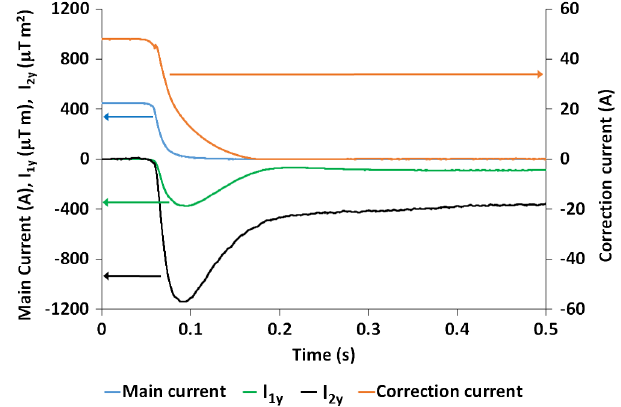
FIG. 12. Measured first and second field integrals during quench